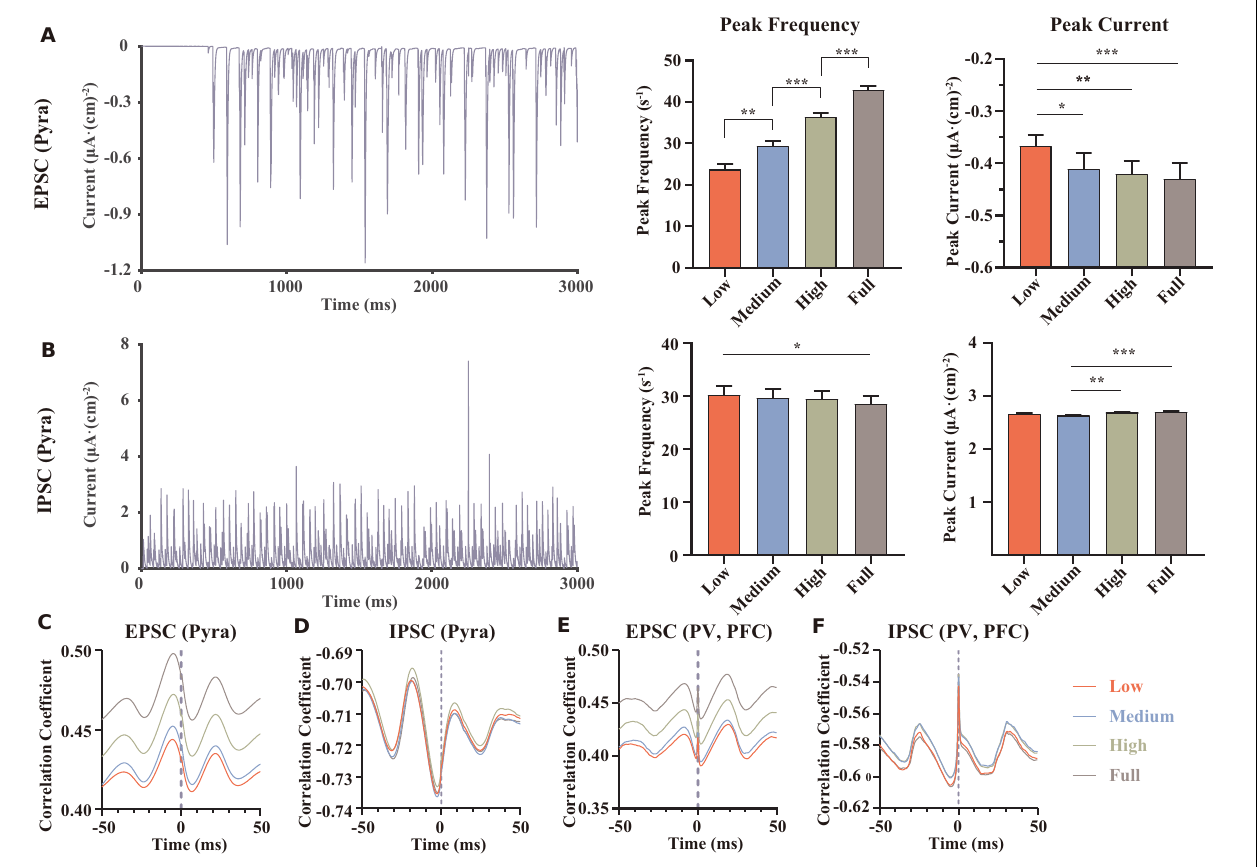
FIGURE 5 | Statistical and correlation results of synaptic currents. (A,B) Examples for an EPSC of proximal dendrite and an IPSC of soma both in pyramidal neurons at low dopamine concentration, then we counted the peak frequencies and the mean amplitude of the peaks (named peak current), n = 9. (C–F) The correlations between the membrane potentials and the synaptic currents of different types of neurons, each result was averaged over 9 independent repeated trials, repeated measured one-way ANOVA (obeying normal distribution) or Friedman test (non-normal distribution), n = 9. All the statistically significant differences were visualized in the graph. * p < 0.05, ** p < 0.01, *** p < 0.001, means ±